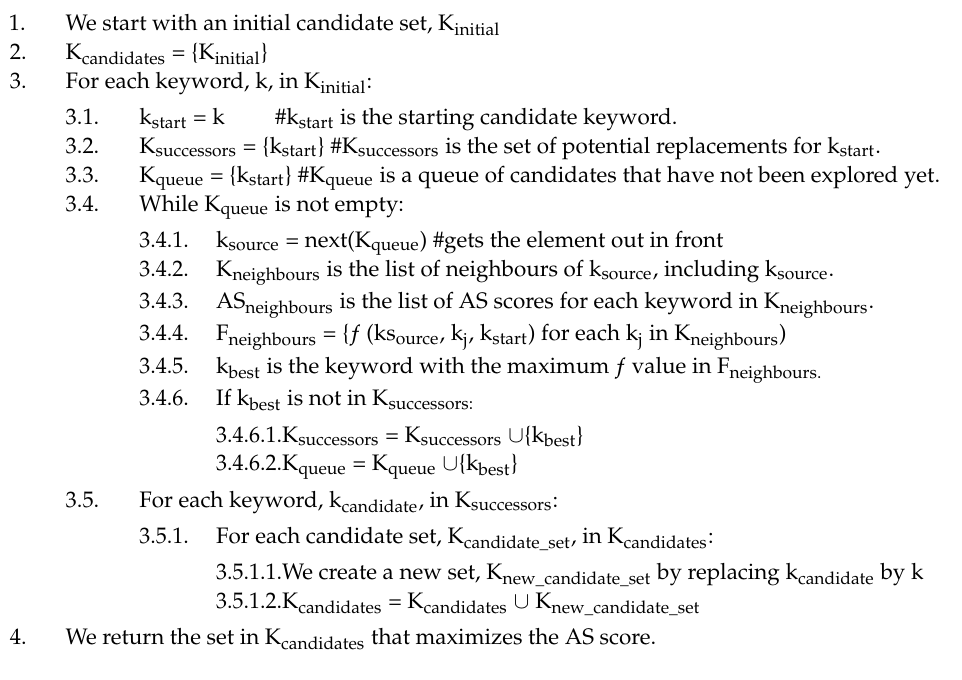
Algorithm 1: Keyword refinement